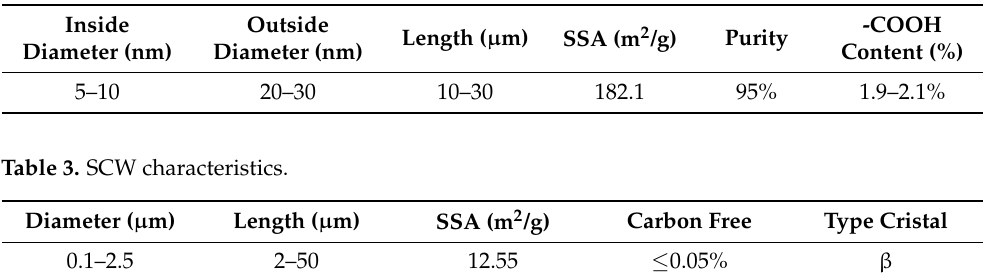
Table 2. CNT characteristics.